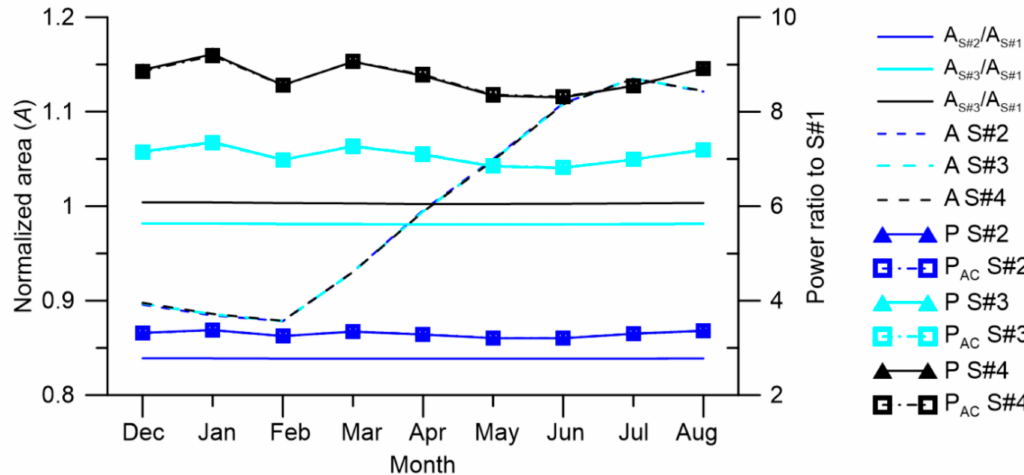
Figure 4. Normalized swept area of the rotor ( A ) for each WT scenario relative to S#1 by calendar month (sold lines). Mean P rx for each WT scenario is shown as the solid line with the triangle symbol. Mean P cx in each calendar month corrected for the variation in A is shown by the squares. There is little spatial variability in the variations of A by month, thus A , P rx and P cx values shown here are a mean of those from the four sites across the